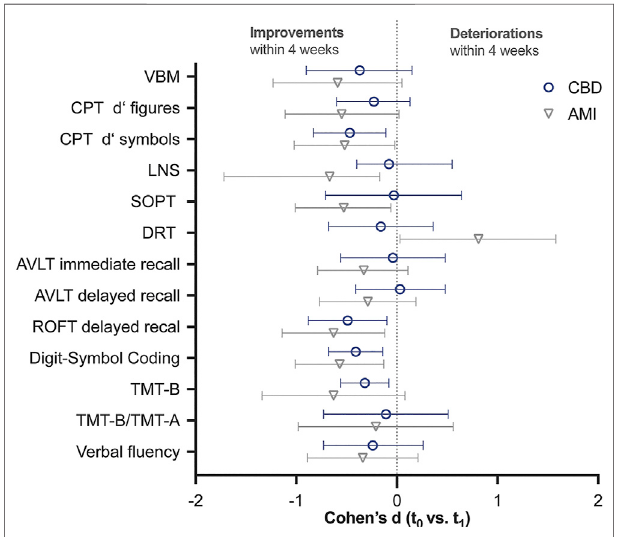
FIGURE 2 | Effect size [Cohen ’ s d (95% CI)] for changes in neurocognitive test scores (t 0 -t 1 mean). Cohen ’ s d for SOPT (#error), DRT (Euclidian distance), TMT-B, and ratio TMT-B/TMT-A (both times in s) have been inverted to allow for a better comparison. Thus, improvements of neurocognitive functioning within four weeks of treatment are indicated by negative effect sizes. 95% CI that do not contain 0, indicate signi fi cant improvements at the 5% level. CBD, cannabidiol; AMI, amisulpride; AVLT, auditory verbal learning test; d ′ , signal detection parameter; DRT, delayed response task, LNS, letter number sequencing; ROFT, Rey-Osterrieth complex fi guretest;SOPT,subjectorderedpointingtask;TMT-A,trail-making test A; TMT-B, trail-making test B; VBM, visual backward